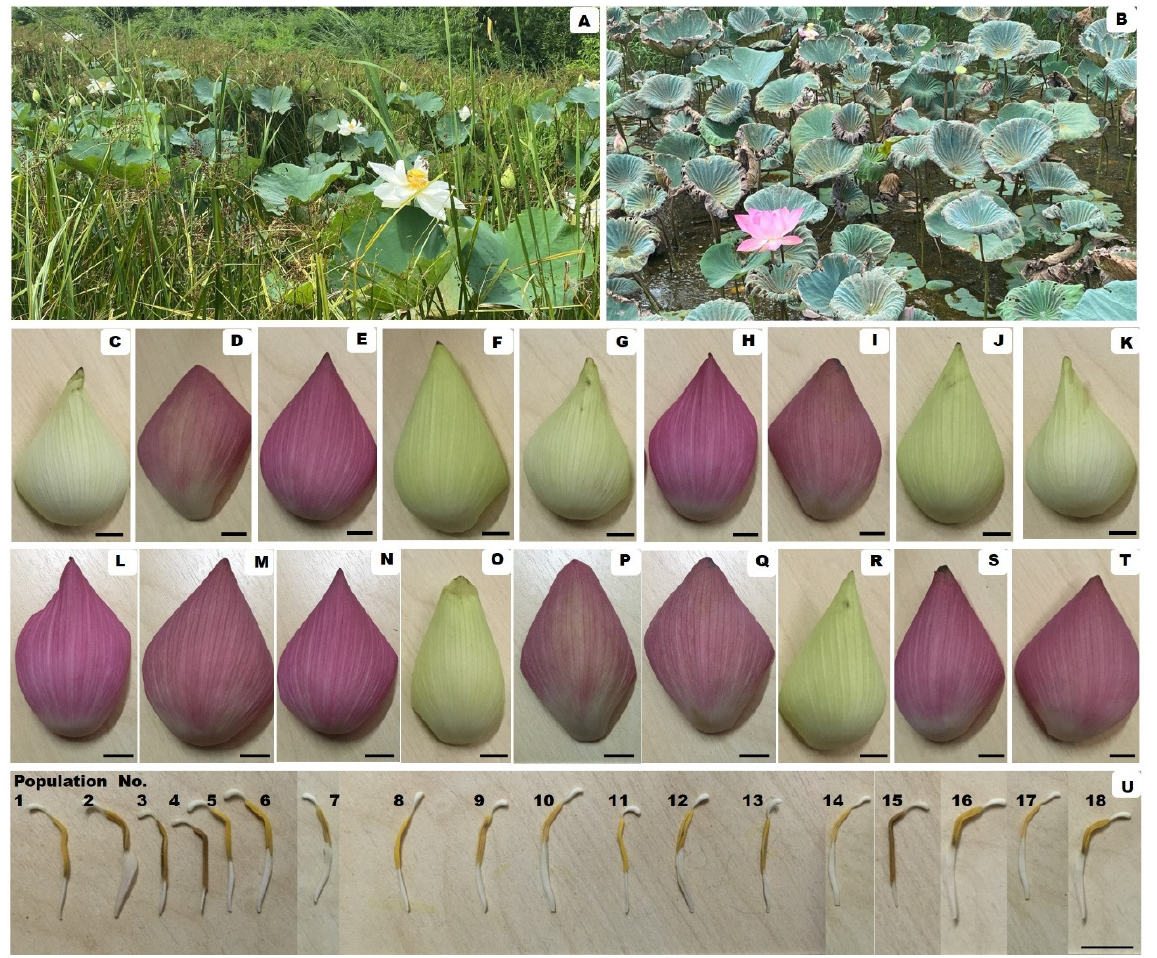
Figure 2. N. nucifera : ( A , B ). Natural habitats; ( C – T ). Perianth of Population No. 1–18, respectively; ( U ). Stamen of Population No. 1–18, respectively; Bar scale = 1 cm. Photo are taken in Thailand by Duangjai Tungmunnithum. Table 1. The collected 18 populations of N. nucifera throughout Thailand. Population